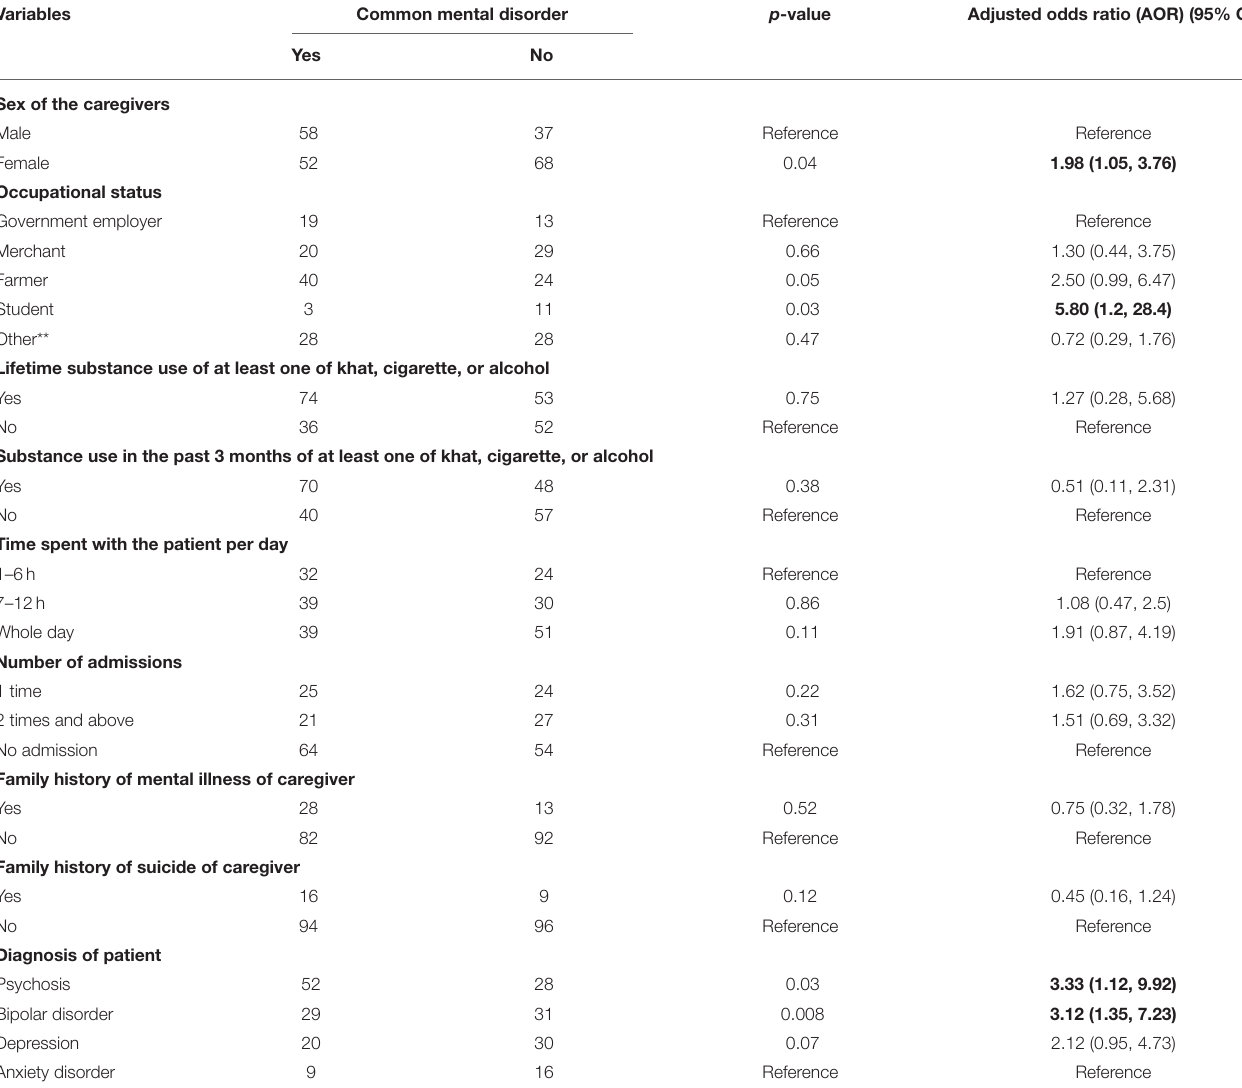
TABLE 4 | Multivariable logistic regression analysis of factors associated with CMDs among primary informal caregivers of adults with mental illness at the HFSUH, Ethiopia,